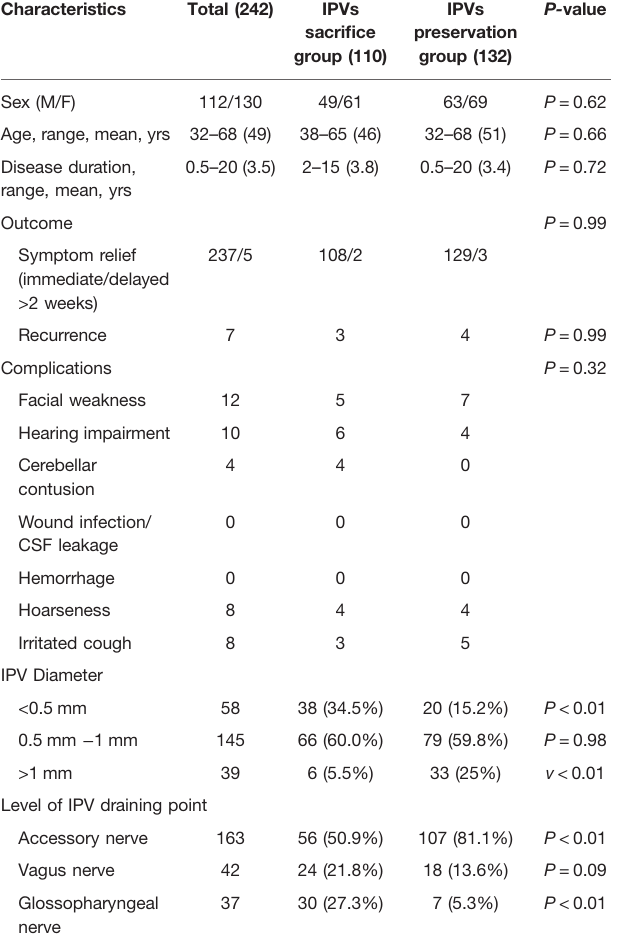
TABLE 1 | Patient characteristics.